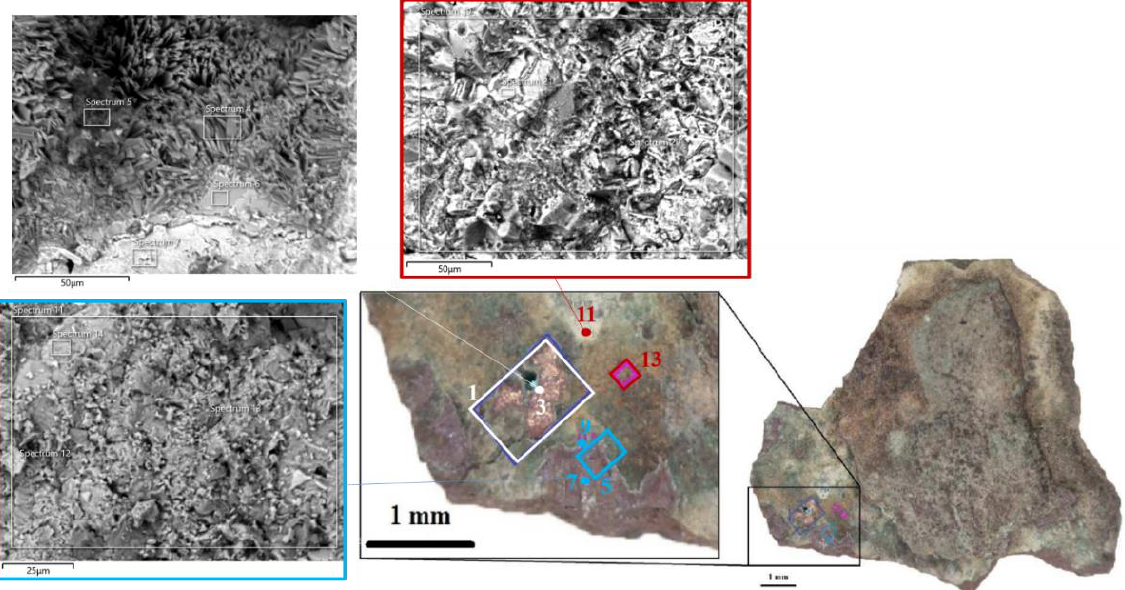
Figure 10. Schematic of the areas investigated by SEM-EDS for sample 13. Area 1 was analyzed in detail in point 3 (colored in white). Area 5, colored in light blue, presented a layer of green patina (detail 9) covered by a rust-colored layer (detail 7). Area 11 represents the white patina and area 13 the orange one (colored in red). SEM images are related to detail 3 (in white), detail 7 (in light blue), detail 11 (in red).